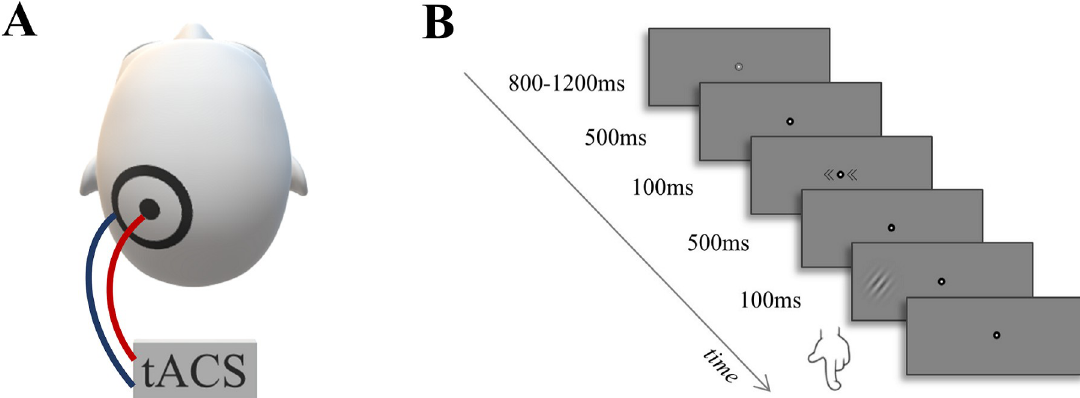
Fig 1. Experimental setup. A. tACS setup. A small circular electrode was positioned over P3 and a large electrode was centring it. Figure adapted from Schuhmann et al. [36] B. Stimulus schematics and trial time course. The trial started with the presentation of a fixation point, followed by a cue (here: left). The target stimulus was a sinusoidal grating tilted at 45˚ to either left or right, presented on either side of the screen (here: presented right). Participants had to indicate the direction in which the grating was tilted. Figure adapted from Schuhmann et al.